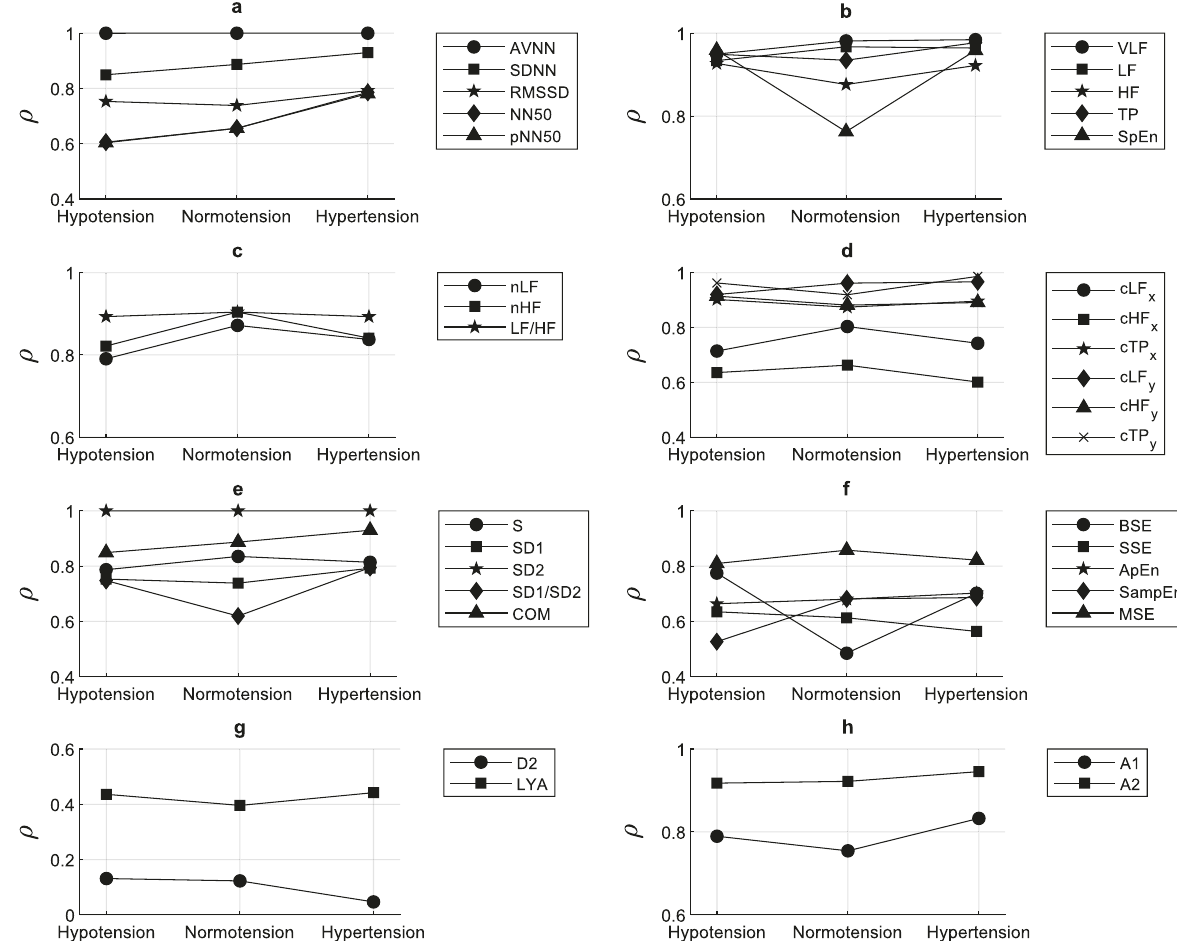
Fig. 1 Linear relationship between pulse rate variability and heart rate variability. Spearman correlation coef fi cients ( ρ ) were measured between a time-domain indices, b absolute and entropy indices from the frequency domain, c relative indices from the frequency domain, d centroid-related indices from the frequency domain, e Poincaré plot indices, f entropy-related indices, g phase-related indices, and h indices resulting from the detrended fl uctuation analysis. All indices were obtained from pulse rate variability and heart rate variability in each blood pressure state (hypotension, normotension, and